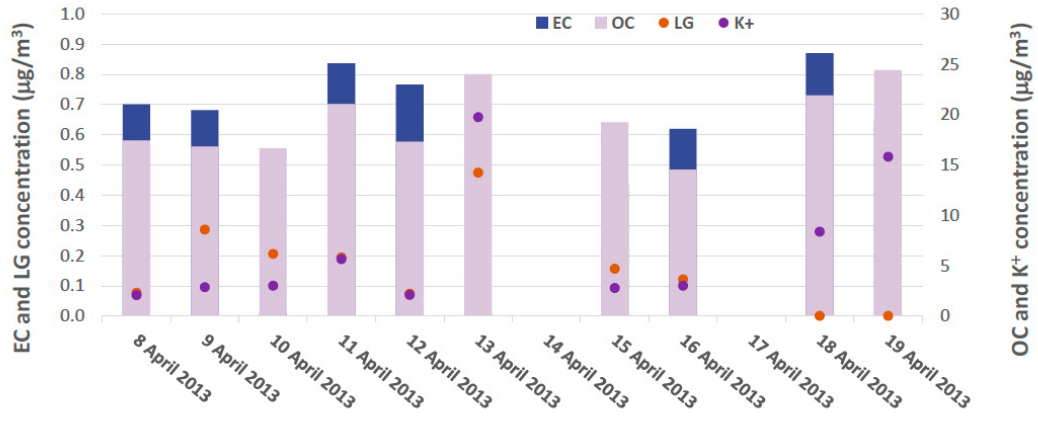
Figure 8. LG, EC, OC and K + concentrations during the second sampling interval for all sampling days. On 7, 14 and 17 April some problems occurred with the sampling system and these filters were not considered.